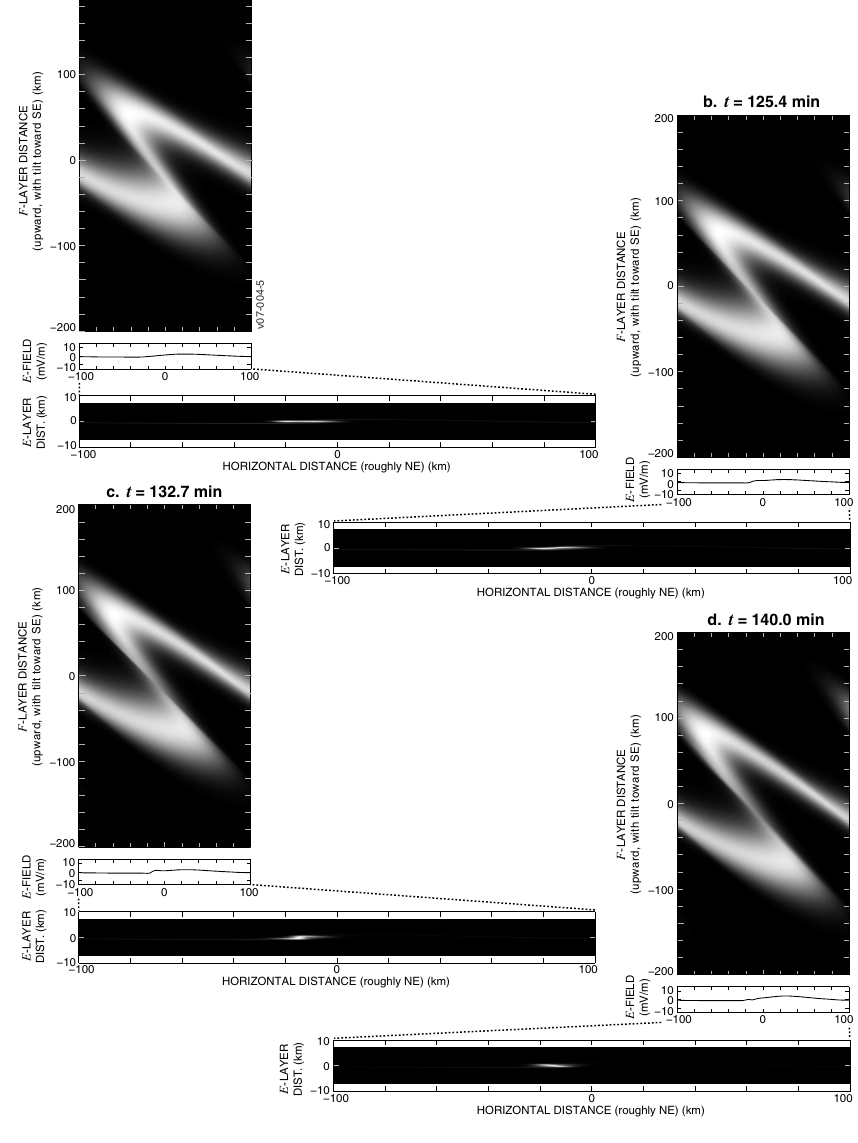
Figure 9: Continuation of the simulation in Figure 8.